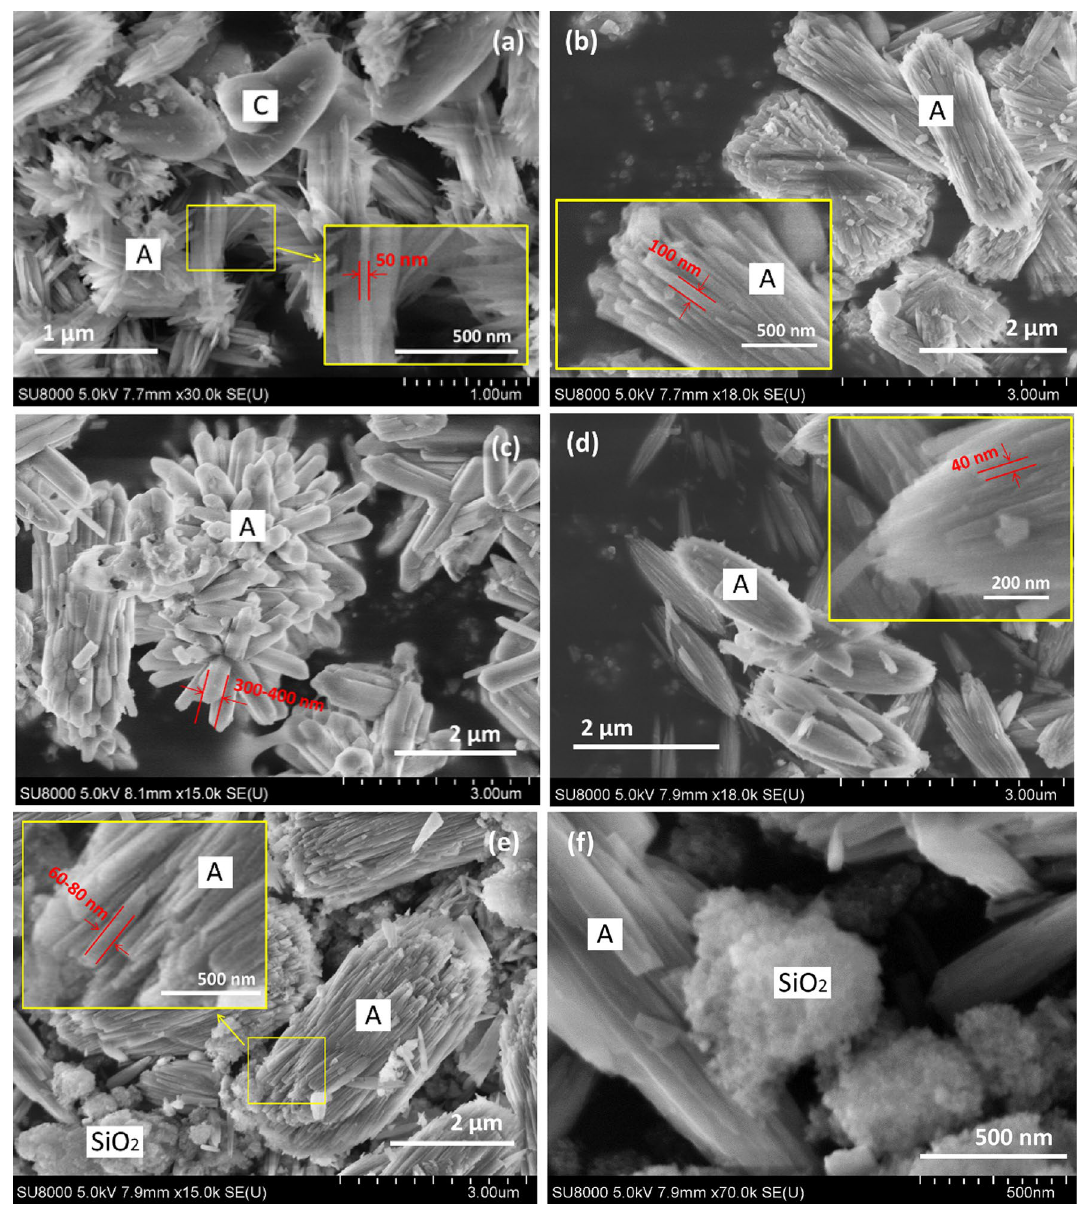
Figure 7. SEM images of CaCO 3 particles produced using ( a , b ) 0.05 M Na 2 CO 3 , ( c ) 0.1 M Na 2 CO 3 ; ( d ) 0.3 M intensity of aragonite peak observed at 26.2° increased from 693 to 2215 arb.u. The fast precipitation of CaCO 3 with the preferred generation of aragonite was consistent with the results of Hirano et al. (2009) 39 . Table 2 lists the mean crystallite sizes determined using 111, 021, 012, 200, and 221 peaks and reveals that high Na 2 CO 3 concentrations increased crystallite size irrespective of the orientation used for measurement. In particular, as the Na 2 CO 3 concentration increased from 0.05 to 0.3 M, the mean crystallite size increased from 19.4 to 58.8 nm, and the width of aragonite particles increased from ~ 50 to 300–400 nm (Fig. 7a–c). The fact that aragonite particles were larger than the corresponding crystallites implies that these particles were made up of several different crystallites 40 . Thus, high CO 32− concentrations favored aragonite crystallization and nucleation in the presence of GLDA. The characteristic XRD peaks of calcite became weaker when the concentration of CO 32− increased from 0.05 to 0.1 M but gained intensity as the CO 32− concentration further increased to 0.3 M (Fig. 6a). The aragonite- to-calcite ratios of each solid sample were semi-determined using MDI Jade 6 under the assumption that all carbonation products were crystalline and detectable by XRD (Table 2). The highest aragonite content of 93.3% was achieved using 0.1 M Na 2 CO 3 , which may be associated with the contradictory effects of CO 32− concentration on aragonite (or calcite) formation. A higher CO 3 2− concentration may enhance the production of calcite 3 but a